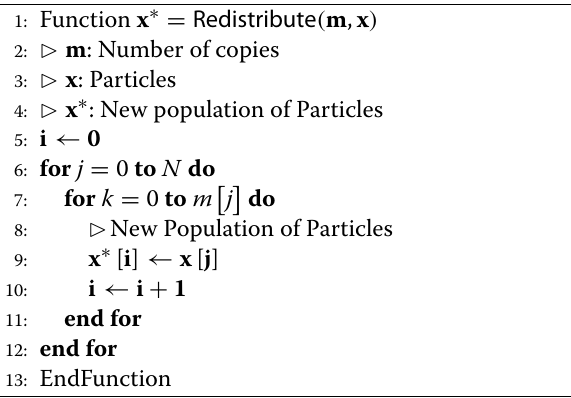
Algorithm 4 Redistribute: O ( N ) implementation.